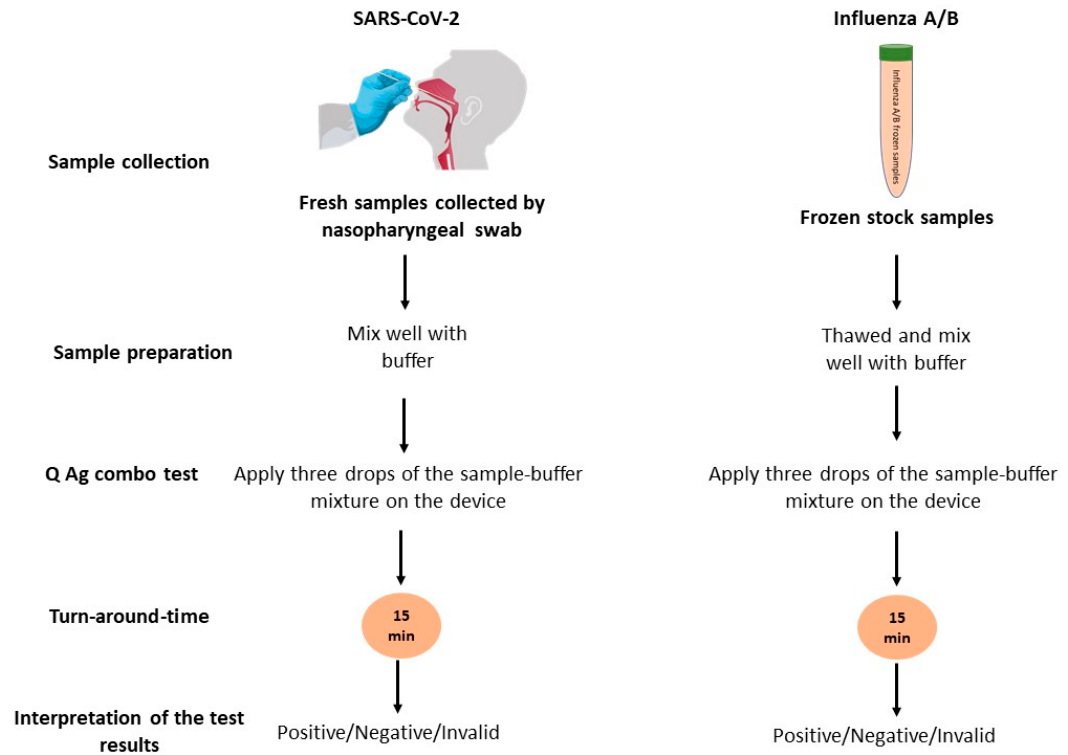
Figure 2. Diagram depicting the test using Q Ag combo. Samples were obtained from participants by nasopharyngeal swab (SARS-CoV-2), or frozen stock (Influenza A/B). Afterwards, the obtained samples were mixed with buffer and about three drops of the mixture were applied to the device. The result can be read and interpreted after 15 min.